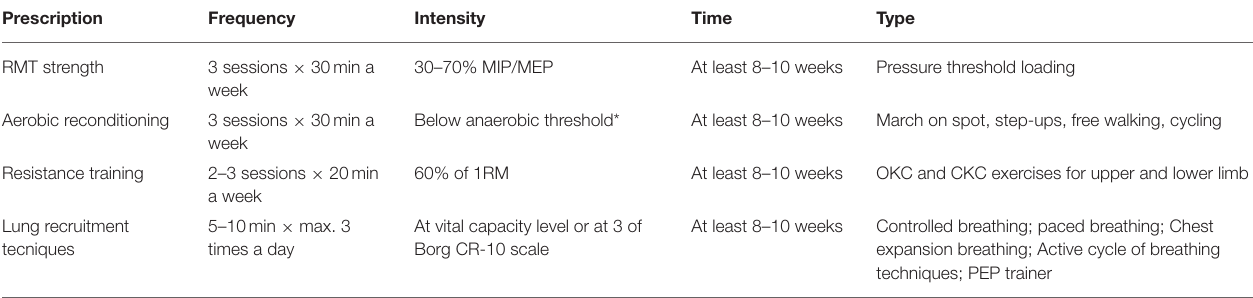
TABLE 4 | Proposal of home-based rehabilitation program for NMDs patients after